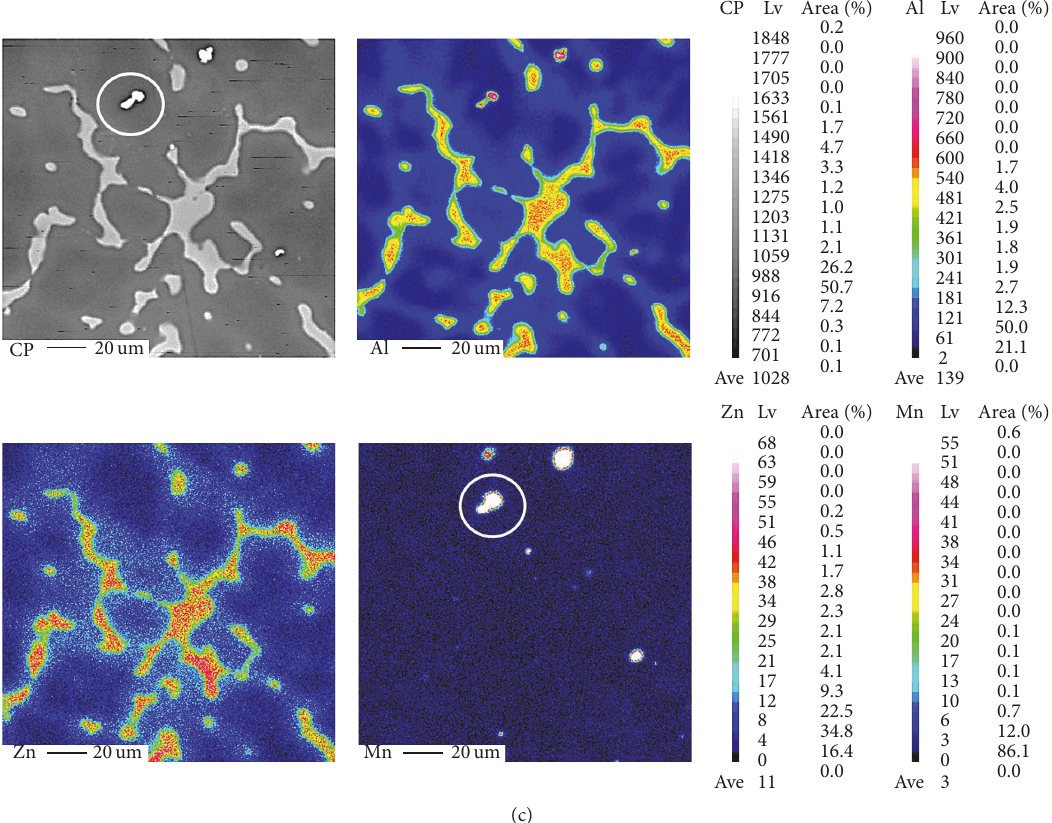
Figure 5: X-ray electron images showing elements distribution in (a) B alloy, 7% Al; (b) C alloy, 9 wt% Al; and (c) E alloy, 14wt% Al. The side bars indicate the intensity of each element. CP = backscattered